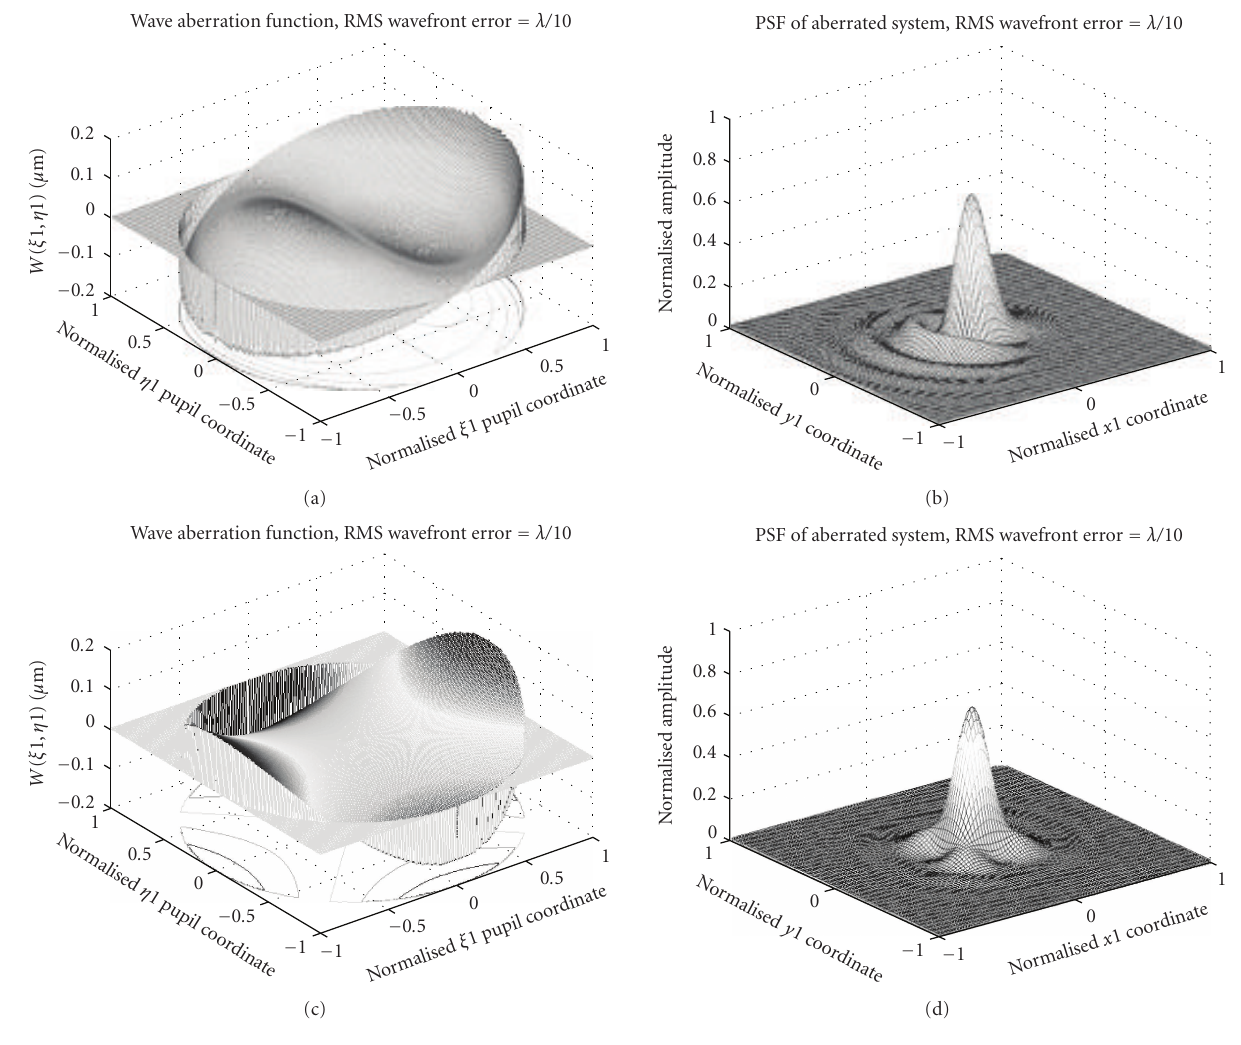
Figure 12: Examples of modelling of optical aberrations in optical all-sky